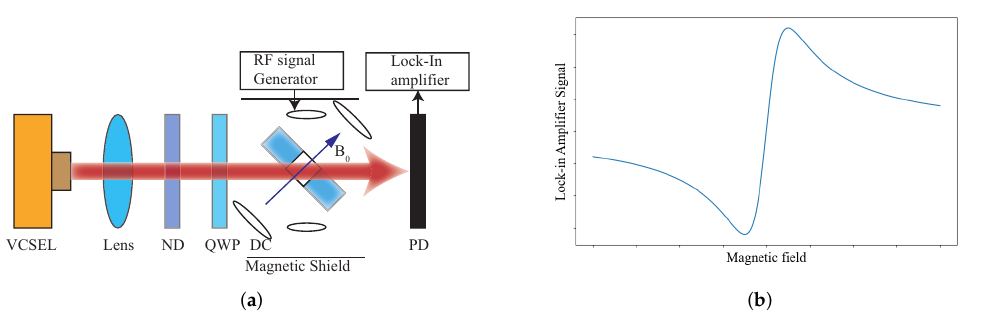
Figure 3. ( a ) Structure of M-x magnetometers; ( b ) dispersive signal as a function of the magnetic